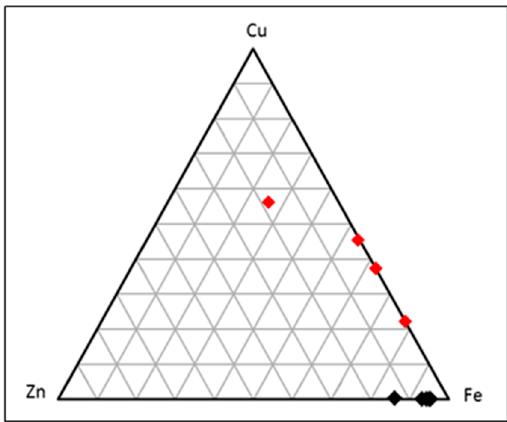
Figure 14. Ternary diagram showing the content of Fe/Cu/Zn in melanterite samples from walls (red) and from stalactites/stalagmites (black).